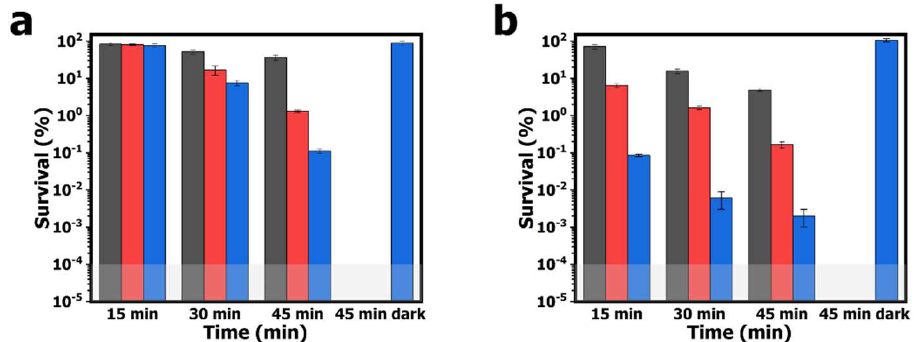
Figure 6. Antibacterial photodynamic inactivation (aPDI) studies employing PAN-PCN 0.1% (dark grey column), PAN-PCN 0.3% (red column) and PAN-PCN 0.6% (blue column) against ( a ) E. coli and ( b ) S. aureus for different illumination